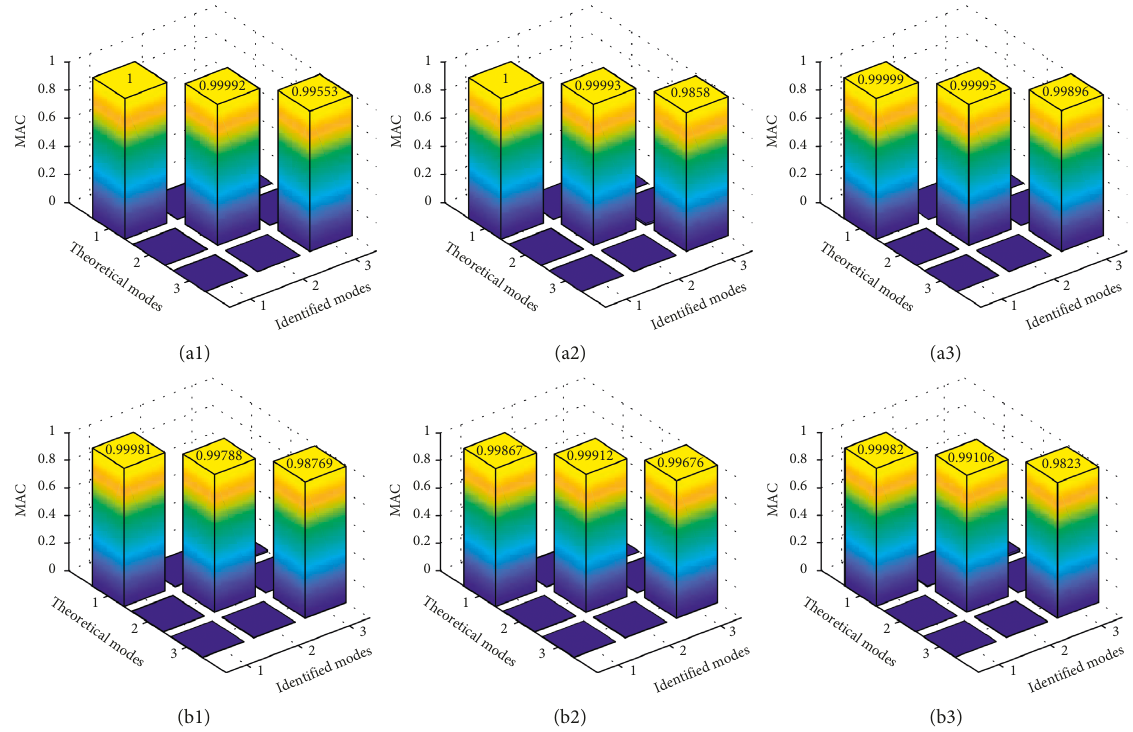
Figure 12: MAC of CoS-SSI results. (a1) CoS-SSI (SNR (b2) CoS-SSI (SNR